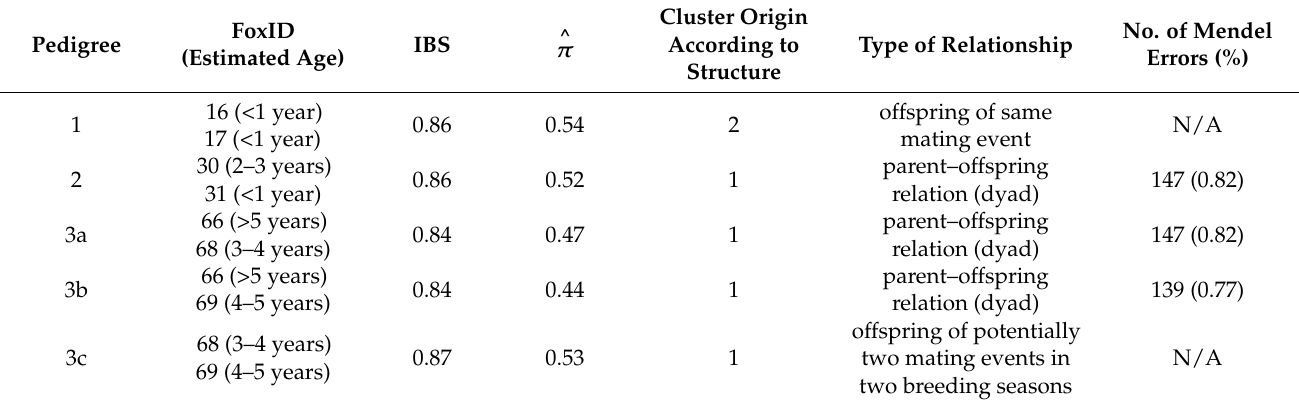
Table 2. Kinship constructs according to information from IDS, IBD ( ˆ π ), STRUCTURE, and basic biology and location data.